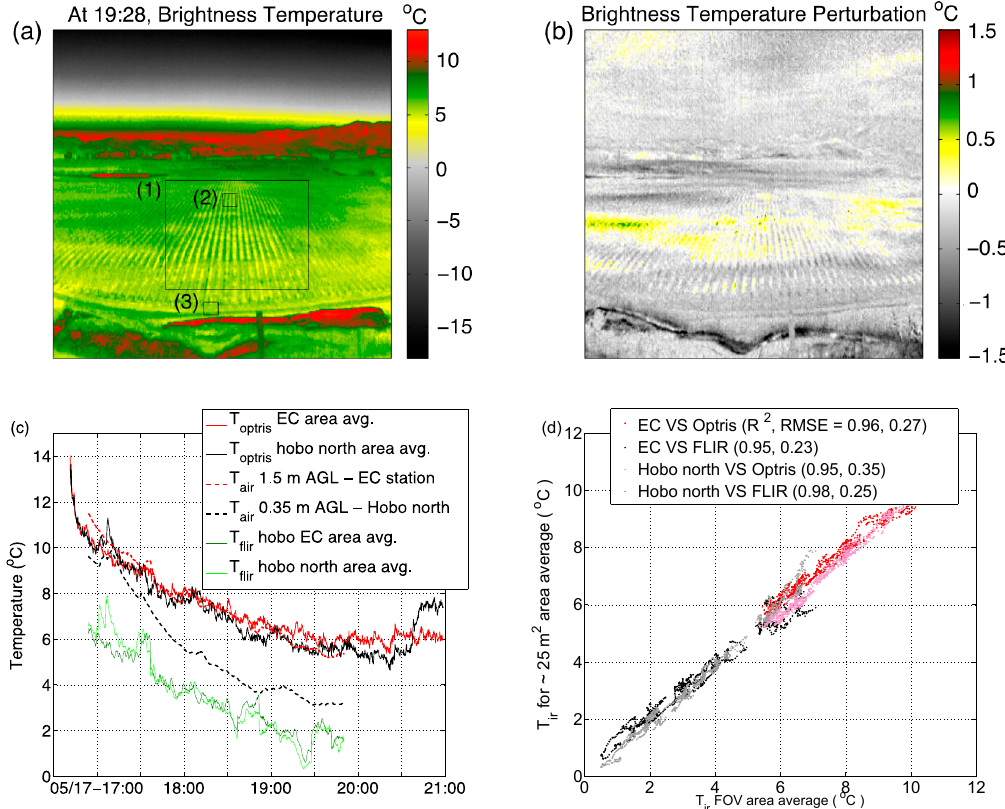
Figure 3. ( a ) A sample snapshot in time of the brightness temperature measured by the Optris camera. Regions (1), (2) and (3) represent the areas from which the mean was calculated from some of the analysis; ( b ) The same snapshot in time as in ( a ) but for the derived perturbation brightness temperature calculated from the deviation of each of the 10 s samples from the 10 min mean. Positive values show areas of increasing temperature in time; ( c ) Time series comparison of brightness temperature from two cameras, air temperature from the eddy covariance station and near-surface Hobo temperature logger; ( d ) Scatter plot of brightness temperature and in situ air temperatures.